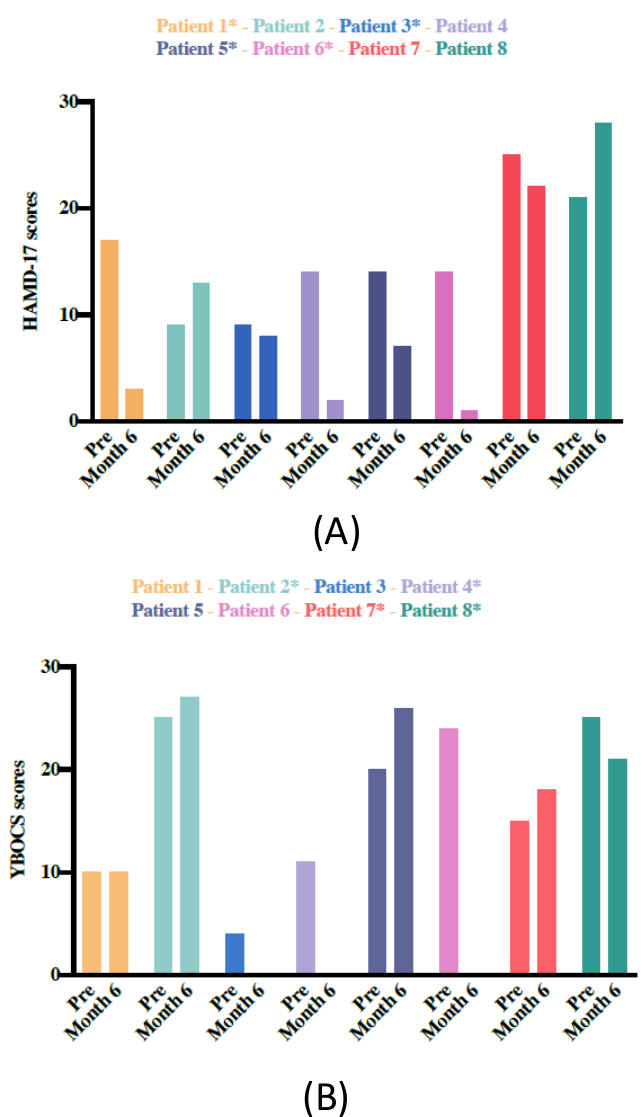
Figure 4. Changes in depression (HAMD-17) and obsessive-compulsive (YBOCS) scores for each patient. ( A ) Changes in depression scores based on the Hamilton Rating Scale for Depression (HAMD-17) from baseline to month 6 post-DBS. Patients identified with an asterisk (*) are those whose main comorbidity was an a ff ective disorder, with SCC stimulation. ( B ) Changes in obsessive-compulsive symptoms based on the Yale-Brown Obsessive-Compulsive Scale (YBOCS) from baseline to month 6 post-DBS. Patients identified with an asterisk (*) are those whose main comorbidity was an anxiety disorder, with NAcc stimulation. HAMD-17 = Hamilton Depression Rating Scale. YBOCS = Yale-Brown Obsessive-Compulsive